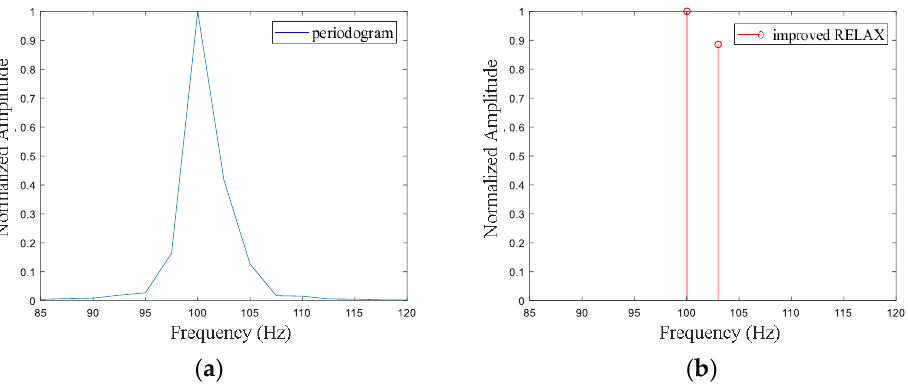
Figure 10. Verification of the minimum frequency interval ( a ) periodogram, which cannot distinguish the 100 Hz and 130 Hz signals, and ( b ) improved RELAX obtaining 100.022 Hz and 102.996 Hz.